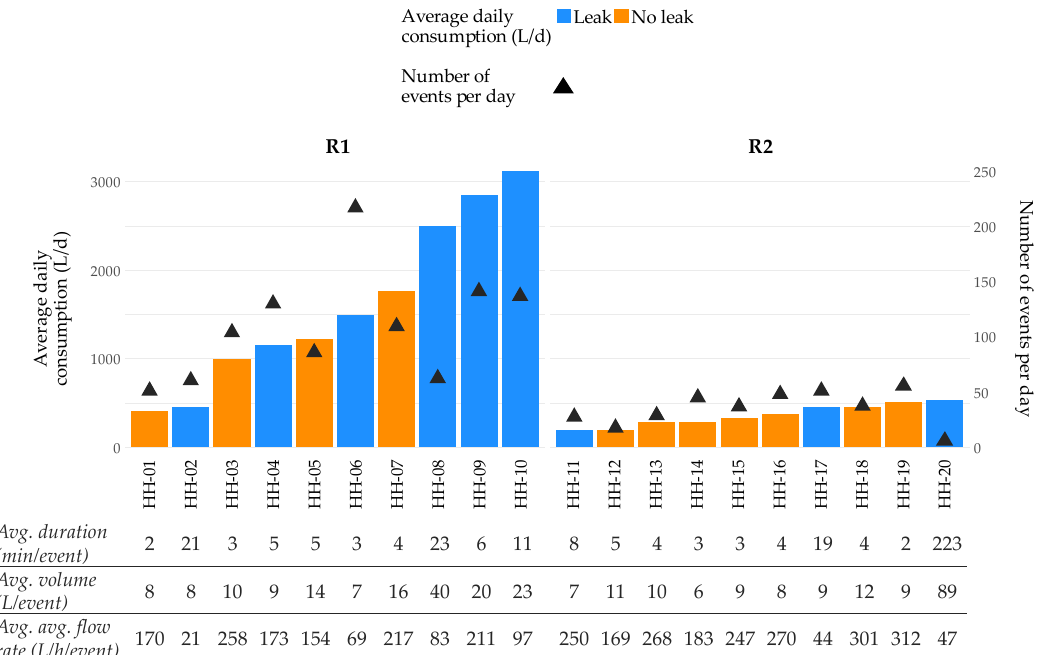
Figure 7. General characteristics of the analyzed households and the events associated with them.